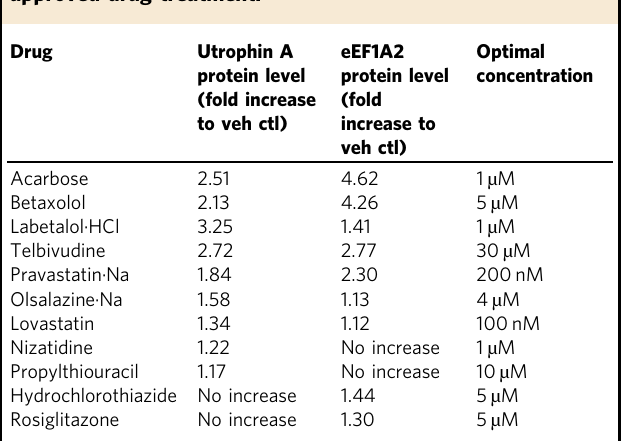
Table 2 Con fi rmation of eEF1A2 and utrophin A protein expression level increases in C2C12 cells, post FDA- approved drug